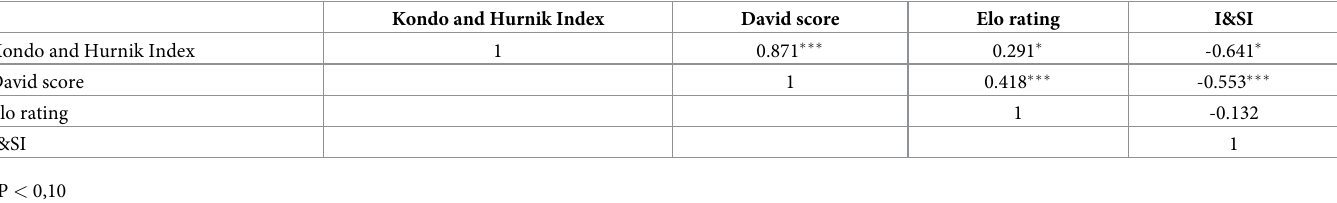
Table 2. Correlations among dominance index for a Nellore cattle group obtained from different methods (Elo Rating, I&SI, and David Score) available on R